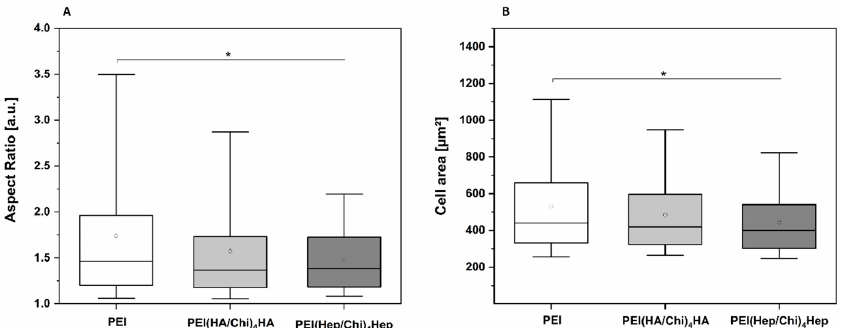
of PEMs composed of either hyaluronic acid (HA) or heparin (Hep) as polyanions and chitosan (Chi) as polycation abbreviated as (PEI(HA / Chi) 4 HA, PEI(Hep / Chi) 4 Hep), respectively. ( B ) Cell area of adherent macrophages per surface area after 24 h of cultivation. The box plot indicates the 25th and 75th percentile; the lowest and highest values are represented by the whiskers, whereas the median (dash) and mean value (white circle) are shown as well. n = 15, * p ≤